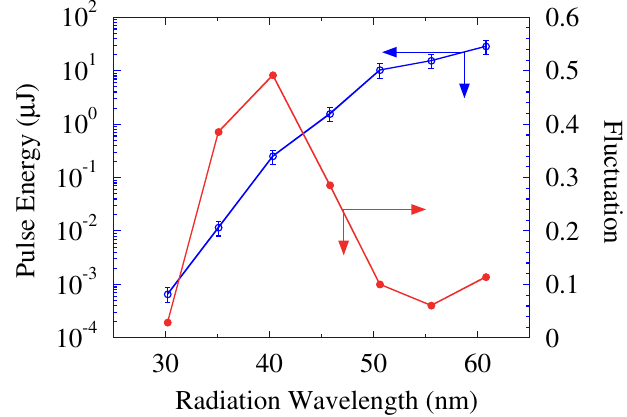
FIG. 10. (Color) Measured SASE pulse energy averaged over 30 shots and pulse-energy fluctuation (STD) as functions of the radiation wavelength. The error bar indicates the uncertainty (30%) for the pulse-energy